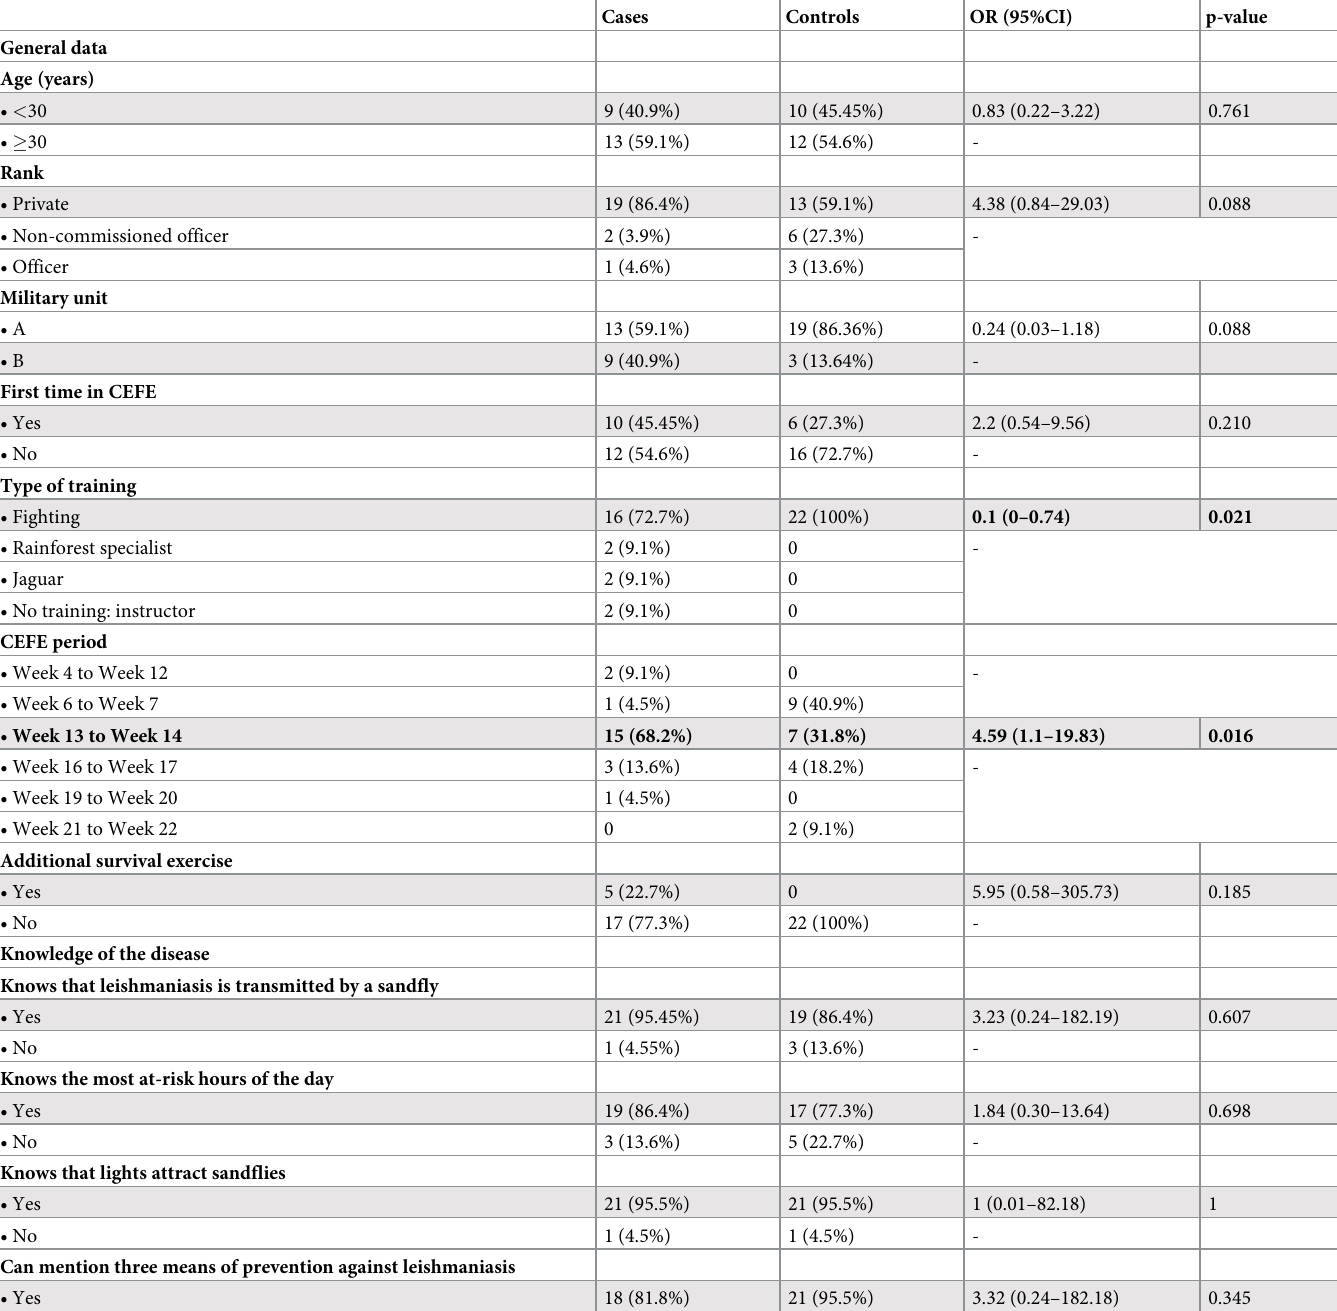
Table 2. Risk factors of Cutaneous Leishmaniasis, case-control study, univariate analysis, confirmed cases of the CEFE outbreak and military controls, French Gui- ana, 2020. Cases Controls OR (95%CI)